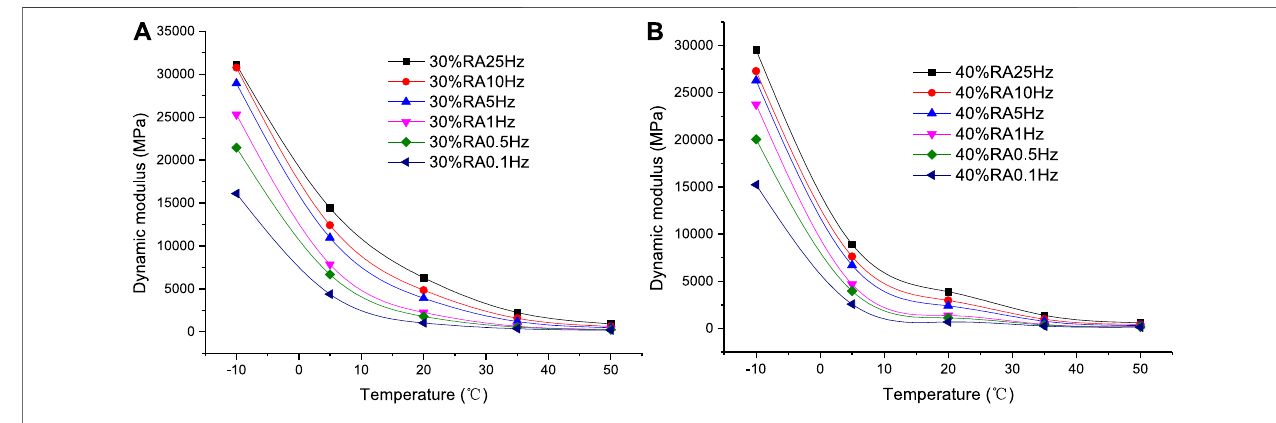
FIGURE 2 | The effect of binder on the dynamic modulus of ARHM13.